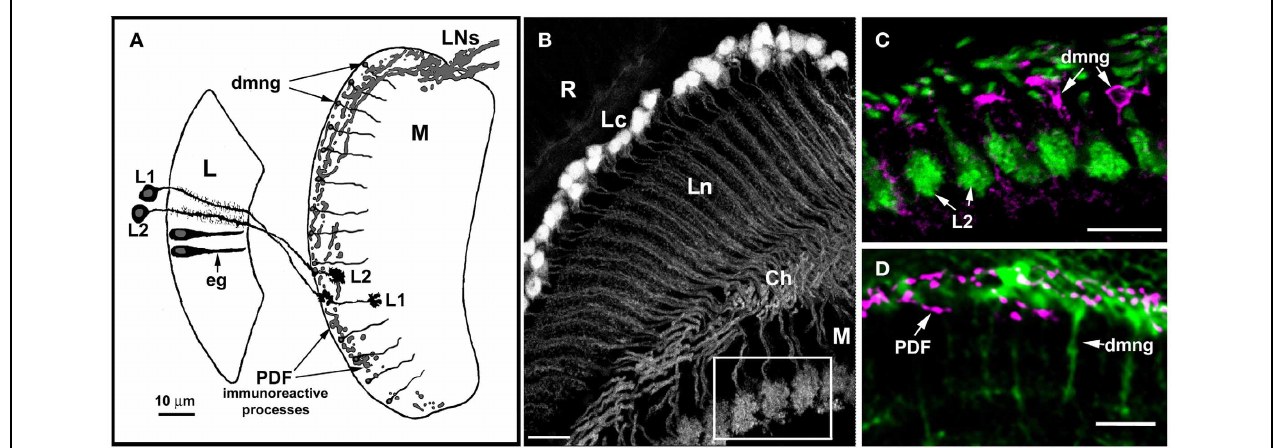
the lamina cortex (Lc); the axons and dendrites of these cells are in the lamina neuropil (Ln), and their terminals in the medulla (M). Ch, external chiasm. Scale bar: 10 μ m. (C,D) The region of the medulla seen as an insert in (B) . (C) GFP labeled terminals of L2 and distal medulla neuropil glia (dmng) showing Ebony-like immunoreactivity. Scale bar: 10 μ m. (D) The distal medulla neuropil glia (dmng) of Repo-Gal4 × UAS-S65T-GFP transgenic flies and terminals of PDH-immunoreactive LNs (PDF) labeled with anti-PDF antibody. The PDF-positive LNs send projections into the region where the terminals of L2 and Ebony-expressing dmng are located. Scale bar: 10 μ